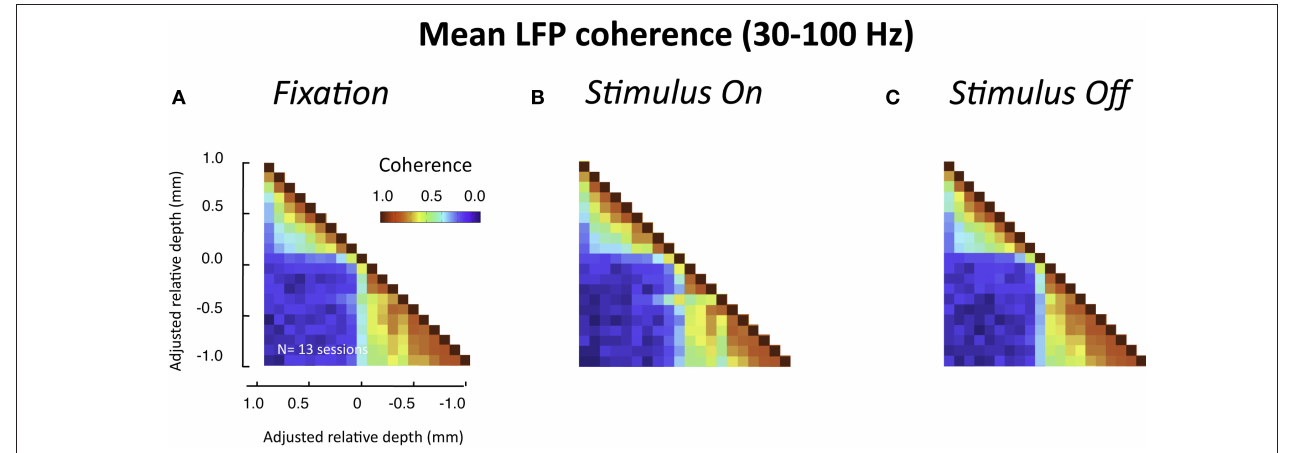
Figure 7 | interlaminar coherence during visual stimulation ( n = 13 sessions, both monkeys). All conventions are the same as in Figure 5B . (A) Coherence pattern during fixation before stimulus onset ( − 300 to 0 ms before stimulus onset). (B) Coherence pattern during sustained presentation of a luminance stimulus onto